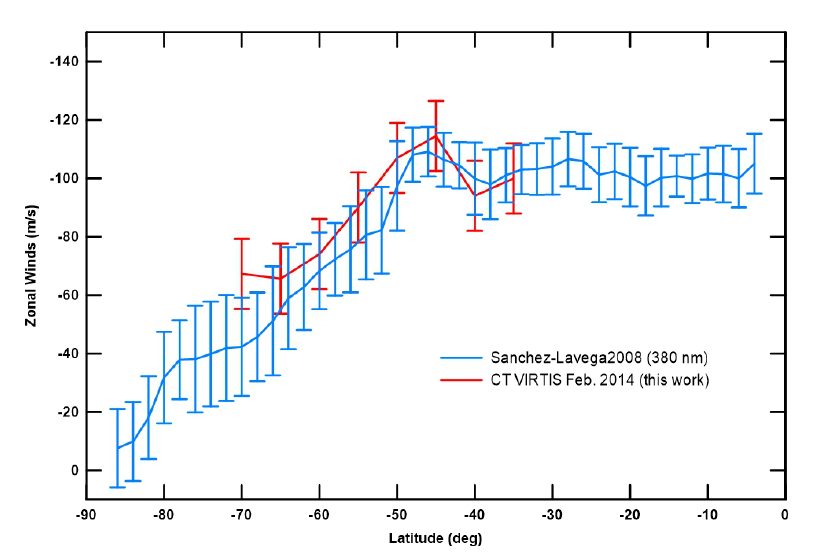
Figure 6. Mean zonal wind latitudinal profile. Here, we present the results from cloud-tracked VEx VIRTIS-M 380 nm images, obtained between 8 and 10 February 2014. The weighted mean zonal winds were binned in a 5 ◦ step latitude interval. For comparison purposes, we also plot the precedent zonal profile obtained by Sánchez-Lavega et al. [19] using the same instrument and wavelength